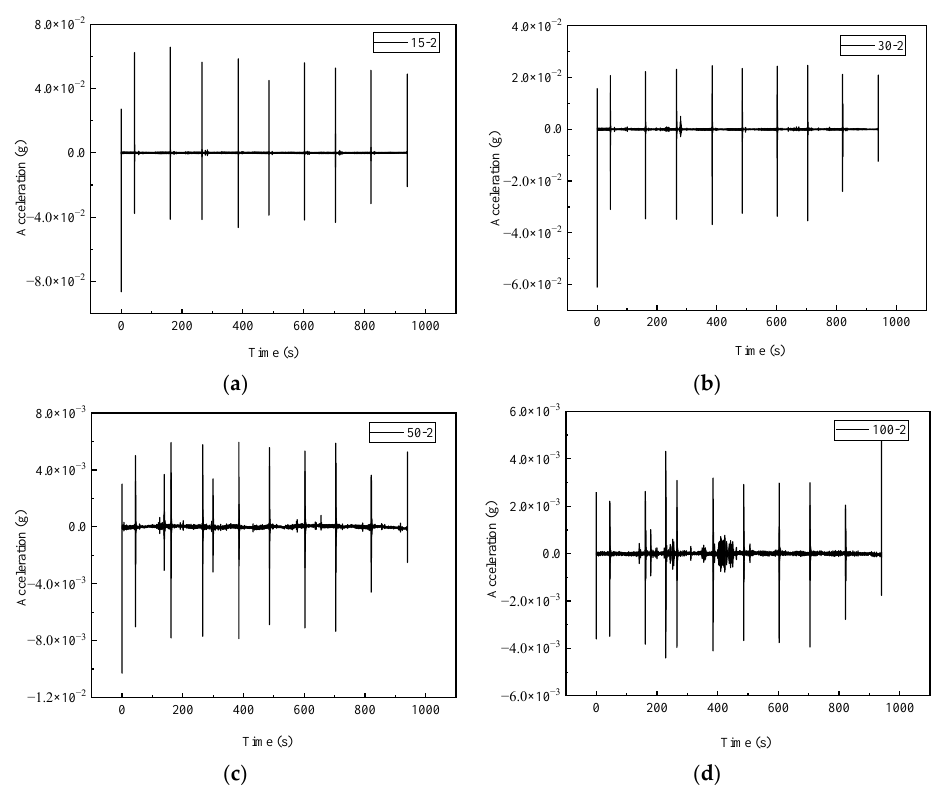
Figure 5. Fourier spectrum curves of acceleration in the vertical direction: ( a ) 15-1; ( b ) 30-1; ( c ) 50-1; ( d ) 100-1.